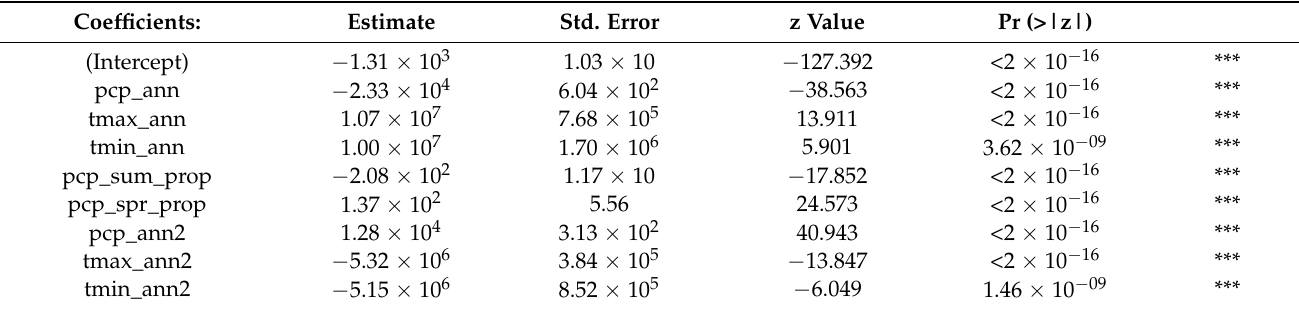
Table 1. Accuracy assessment of the best-performing models. Goodness-of-fit measures: AIC (Akaike information criterion), logLik (log-likelihood function), deviance (residual deviance), and df.resid (degrees of freedom — residual). M1 includes annual precipitation, annual maximum temperature, and summer precipitation; M2 adds to M1 the squared and logarithmic transformations of its variables; M3 adds on to M2 the interactions between each one. The selected model adds spring precipitation to M3.